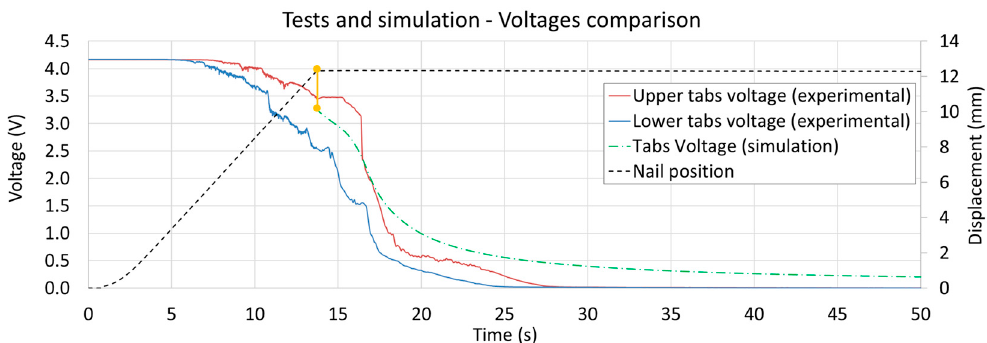
voltage around the nail is markedly lower than the voltage measured at the tabs.